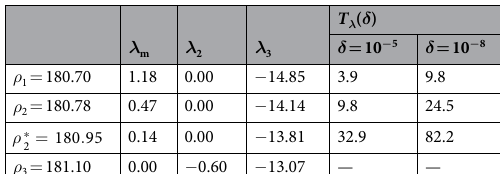
— — Table 1. The average maximal Lyapunov exponent λ m together with the second- and third largest Lyapunov exponent, λ 2 and λ 3 (cf. Methods section). The respective Lyapunov prediction times T λ have been evaluated for the two sets of initial distances δ used in Fig. 3. The values of ρ used are indicated in Fig.